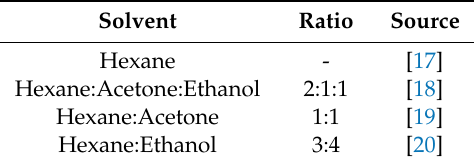
Table 1. List of extraction solvents utilized in this